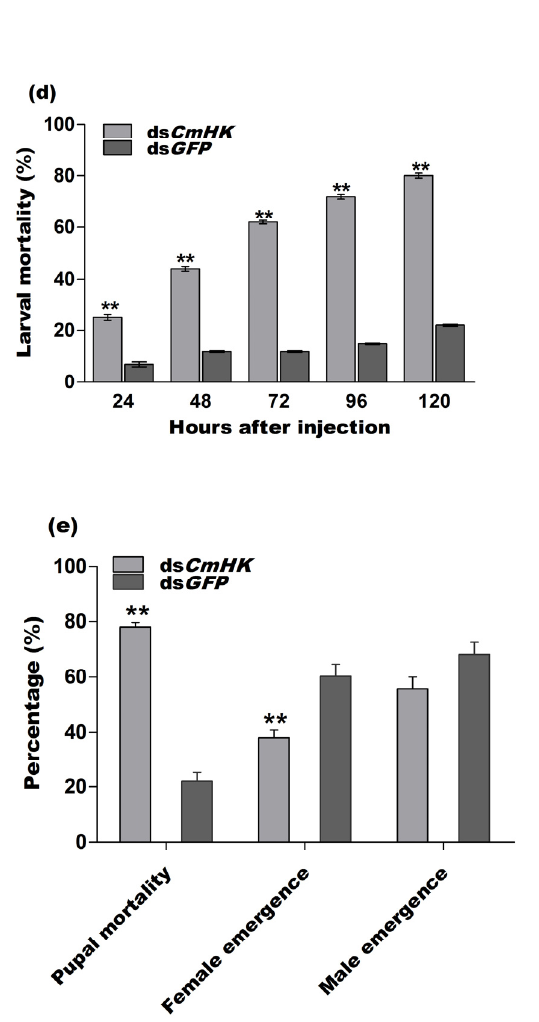
Figure 6. Phenotypic expressions, average weight loss, abnormality, larval and pupal mortality rates, and male and female emergence rates in response to injection with ds CmHK as compared to ds GFP in C. medinalis . Twenty larvae were selected in one group for injection as a replicate. ( a ) Abnormal phenotypic expressions (larvae and pupae). ( b ) Average weight loss at 24-h interval (24 h – 120 h). ( c ) Abnormality rates. ( d ) Mortality rates 24–120 h after ds CmHK and ds GFP injection. ( e ) Pupal mortality of injected larvae after pupation formation, and male and female emergence ratio. Each bar indicates the mean ± SD and significant differences are indicated by ** ( P < 0.05).